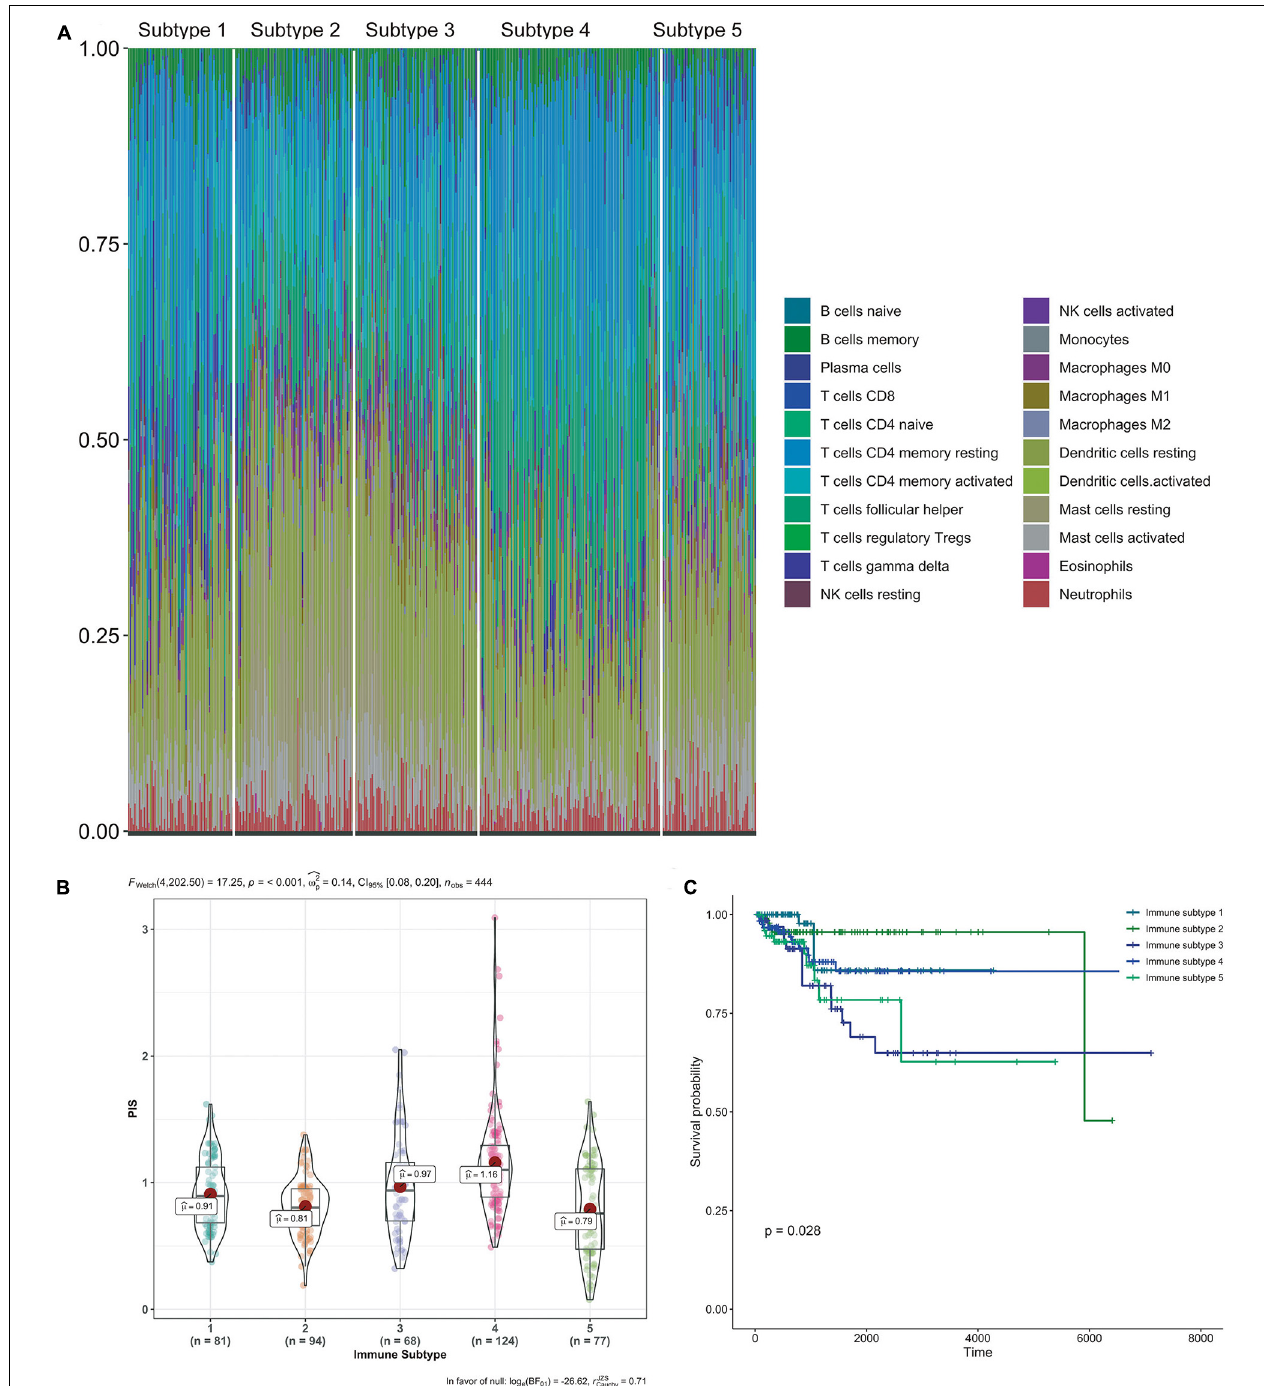
FIGURE 6 | Immune subtypes in patients with gynecological malignant tumors. (A) Unsupervised clustering of all samples based on immune cell proportions. Stacked bar charts of samples ordered by cluster assignment. (B) Risk score in different immune subtypes. (C) Survival analysis of patients within different immune